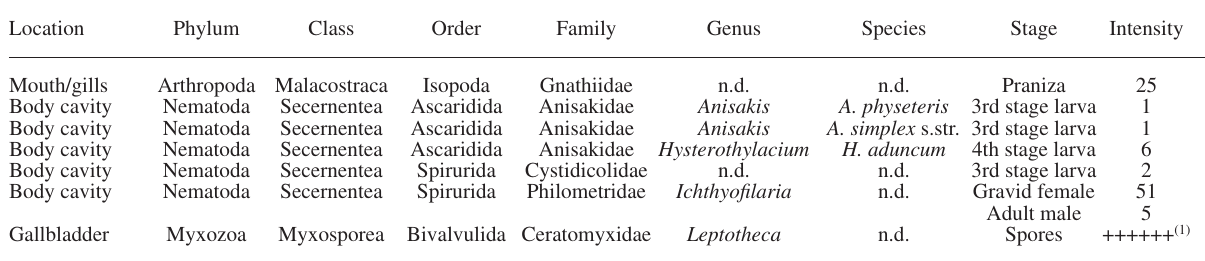
Table 2. – List of the parasites found in the Gaidropsarus granti specimen